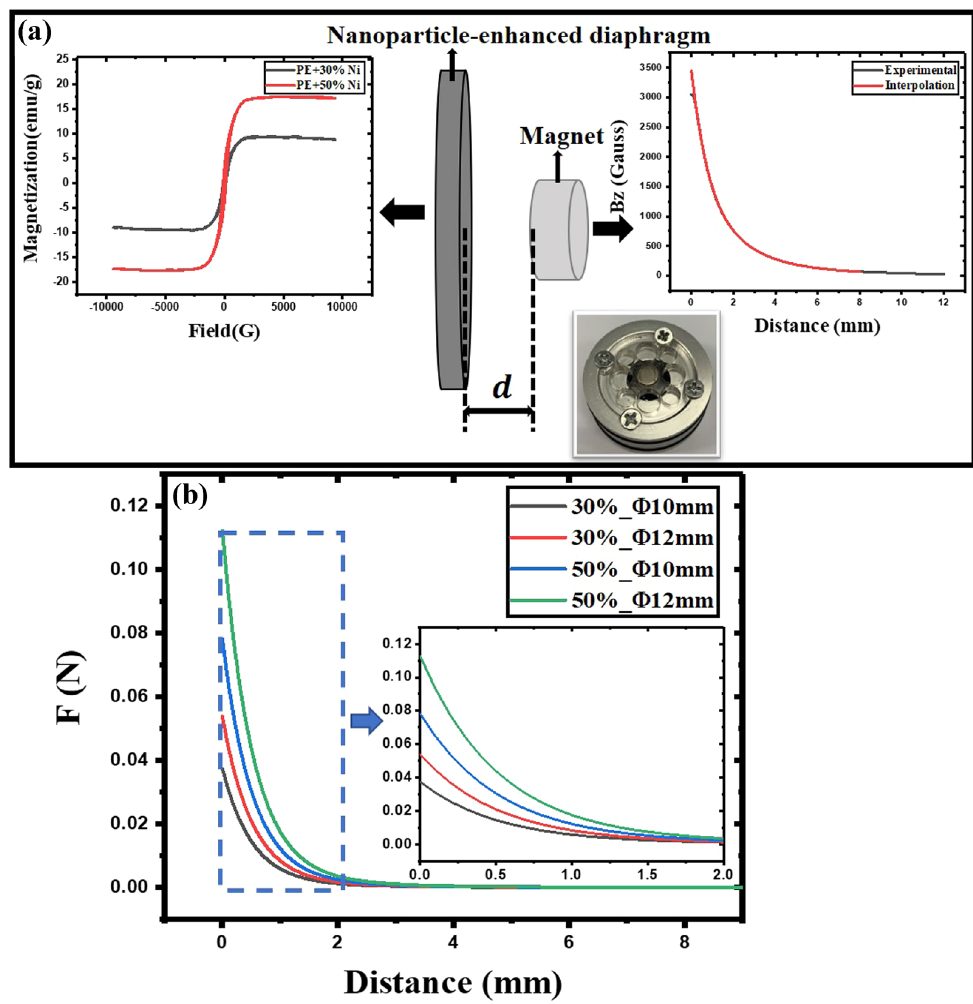
Figure 2. ( a ) The nanoparticle-enhanced diaphragm and the cylindrical magnet with a distance d from diaphragm, the lower right picture is the actual prototype used for testing. The left picture shows the vibrating- sample magnetometer (VSM) measurement results with different magnetic membranes, and the picture on the right shows the measured and interpolated values of the magnetic field at different positions of the magnet on its central axis. ( b ) When the cylindrical magnet has been determined to be a magnet with a magnetic field distribution on the right side of the ( a ), different nanoparticle-based diaphragms are subjected to magnetic forces at different distances from that magnet. The zoom in of the force applied to the magnetic membranes from 0 to 2 mm, respectively is shown in the